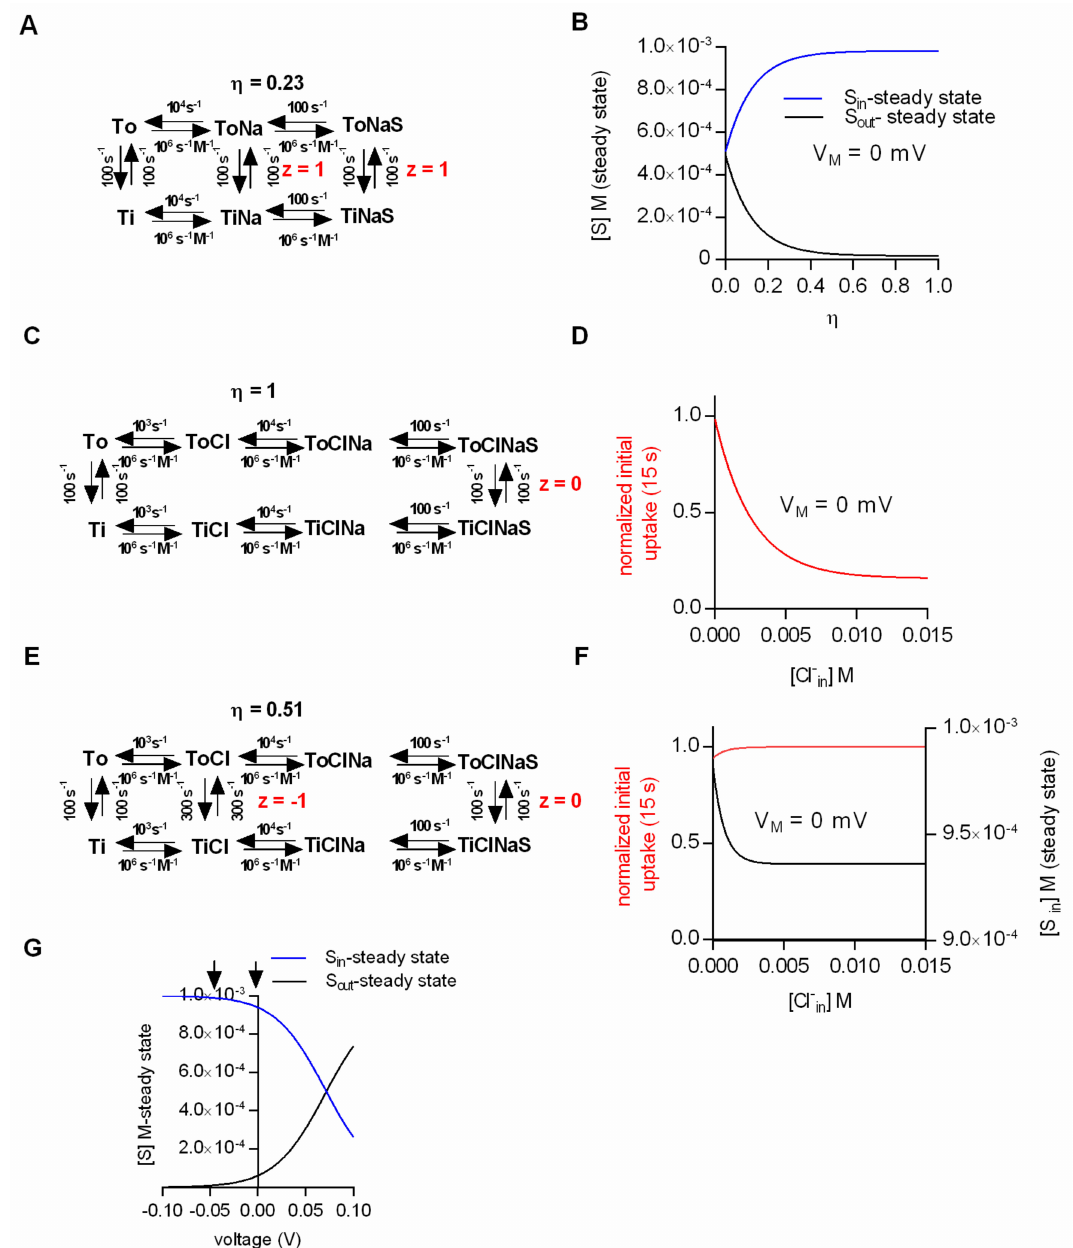
Figure 2. Substrate transport at low conversion e ffi ciencies. ( A ) Scheme of a transport model with low Na + / substrate conversion e ffi ciency ( η = 0.23). The kinetic model allows for Na + slippage. ( B ) Steady-state substrate concentrations as a function of the conversion e ffi ciency ( η ). The membrane potential in the simulation was set to 0 mV. ( C ) Scheme of a transport model in which the conversion e ffi ciency ( η ) is 1. ( D ) Simulated normalized initial uptake as a function of the intracellular Cl − concentration for the scheme in C. V M in the simulation was 0 mV. ( E ) Scheme of a model for which the coupling e ffi ciency ( η ) is 0.51. The model allows for Cl − slippage, but fully utilizes the electrochemical potential of Na + . ( F ) Simulated normalized initial (red line) and steady-state uptake (black line) as a function of the intracellular Cl − concentration at 0 mV. ( G ) Intra- and extracellular substrate concentrations at the steady state as a function of voltage calculated for the scheme in E. The arrows indicate the voltages that were compared in the vesicular preparation